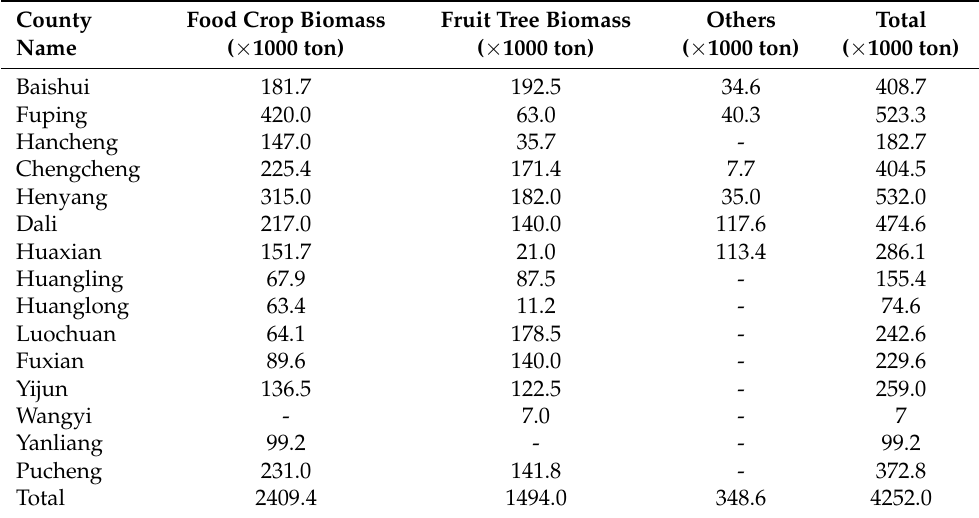
Table 1. Available biomass resources in the area with collection diameter 100 km (unit: × 1000 ton).